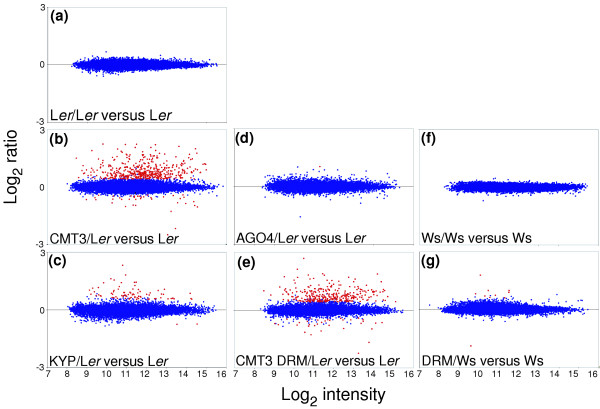
Raw data plots for the gene-oligo array. For each genotype pair, the average log2(exp/ref) ratio is plotted versus the corresponding average log2 fluorescent intensity. Each plot contains the results of six array measurements, that is dye-reversed measurements on three biological replicates. All data were lowess normalized as described in the Materials and methods section. Red dots represent statistically significant target loci, where those with positive log ratios indicate hypomethylation and those with negative log ratios indicate hypermethylation. Blue dots represent the rest of the loci.